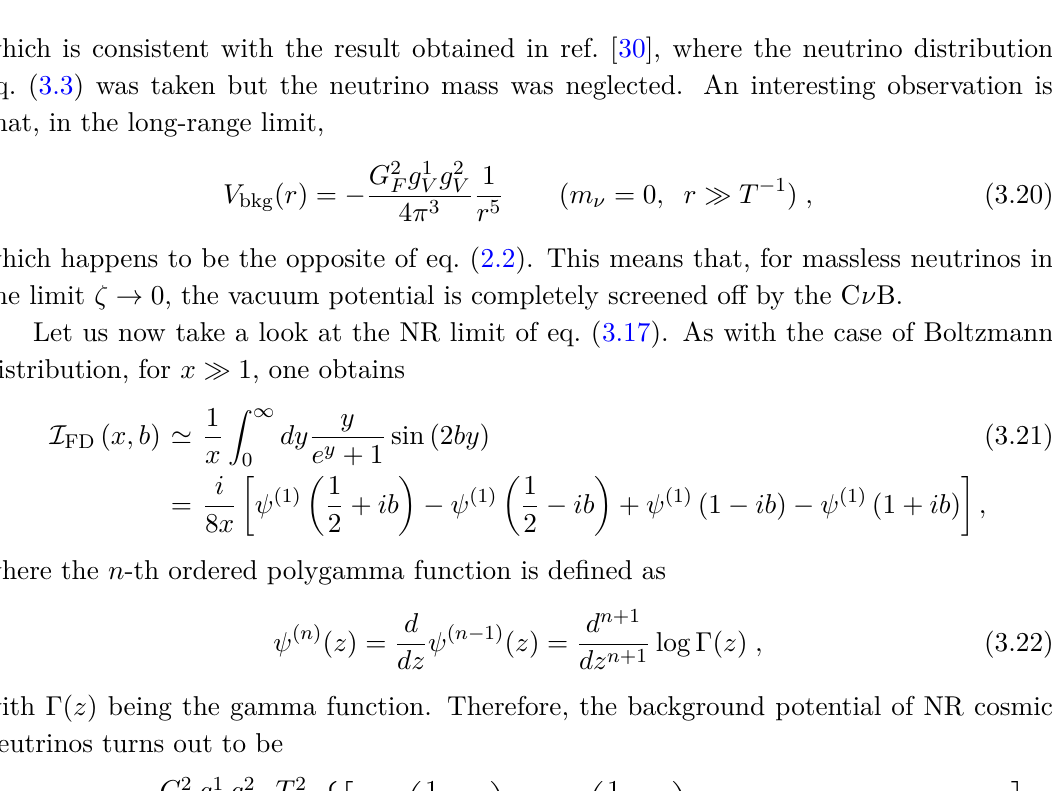
Table 2 . Comparison of the short- and long-range behaviors of the background potential V bkg ( r ) in the massless and non-relativistic limits with the neutrino Background Distribution Function ( ν BDF) taking the Maxwell-Boltzmann (MB) distribution in eq. (3.1) and Fermi-Dirac (FD) distribution in eq. (3.4). We have neglected the chemical potential in both distribution